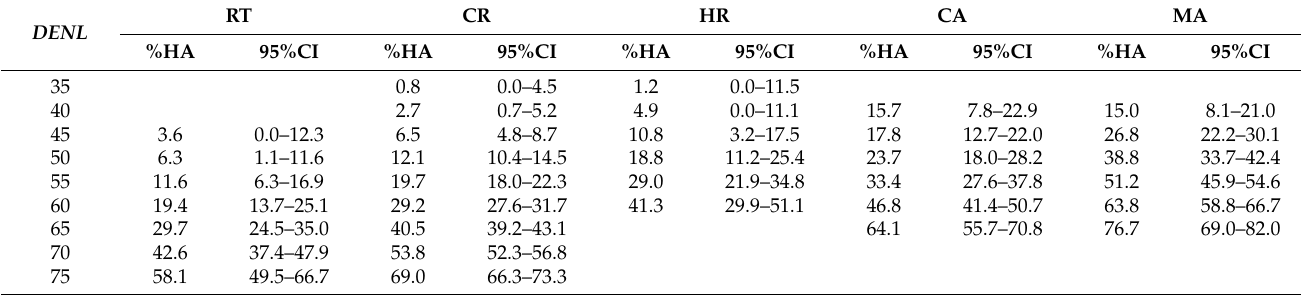
Table 9. Estimated %HA and 95% confidence interval of quadratic regression for 5-dB steps of L den by transportation noise. DENL